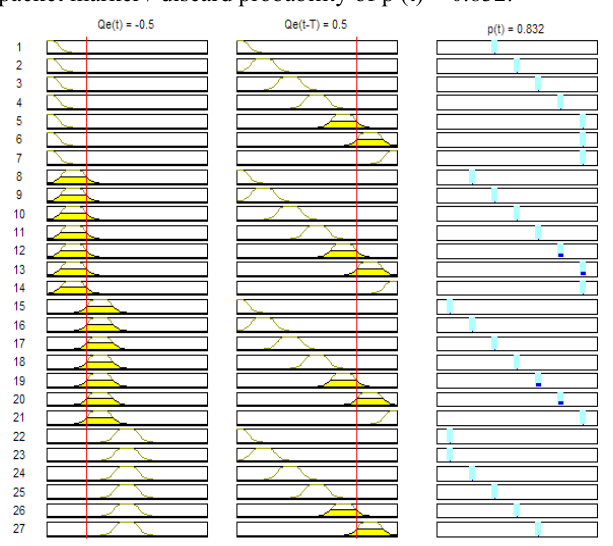
Figure 8. Illustrate calculating output of FLRED